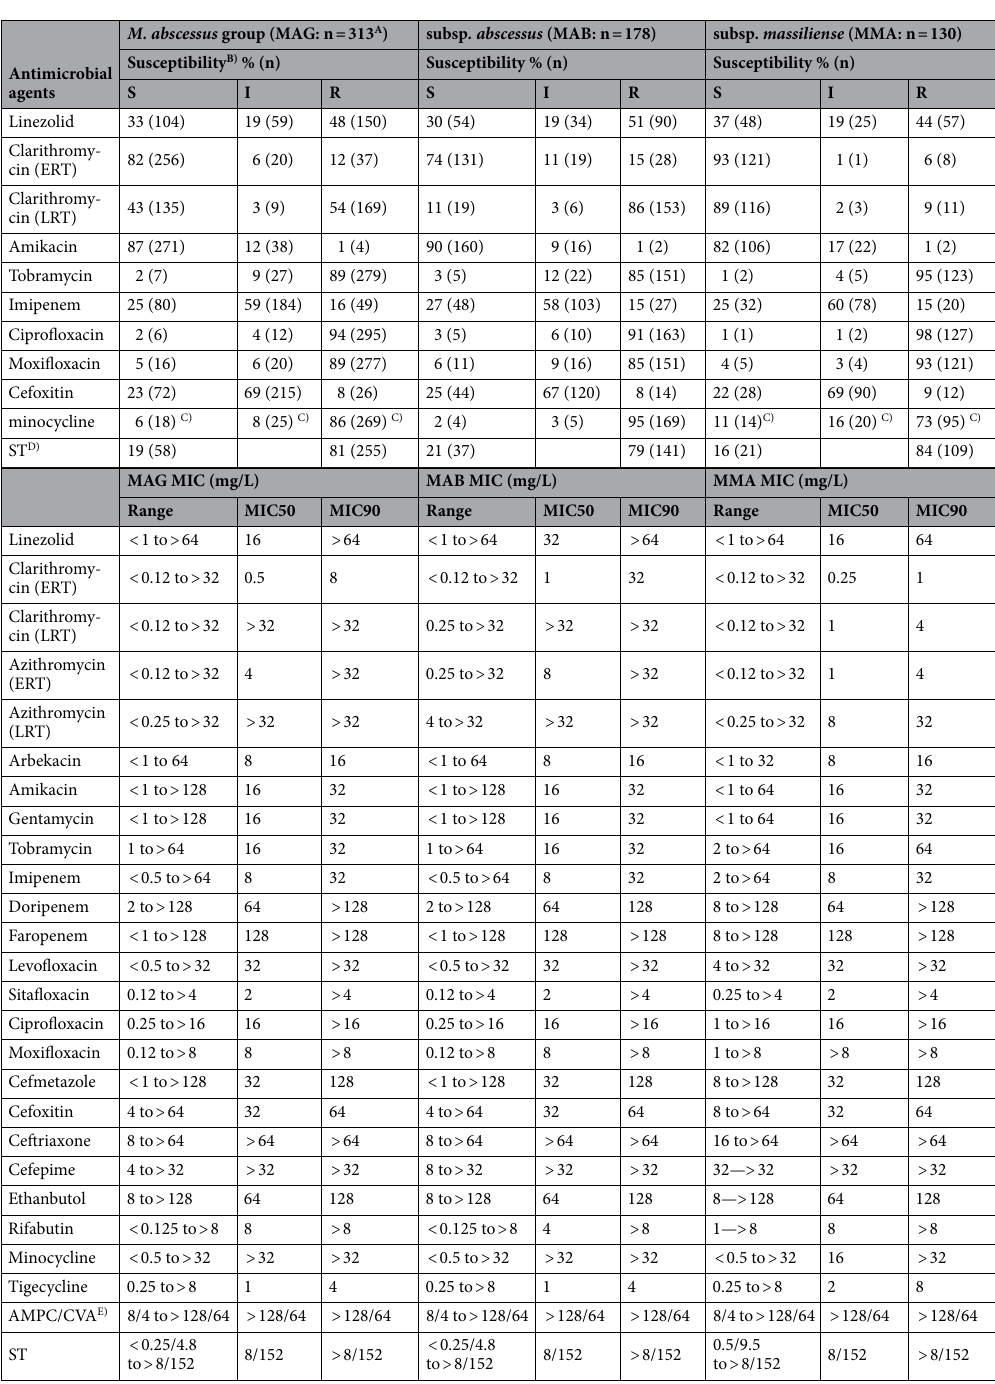
Table 2. Antimicrobial susceptibility of Mycobacteroides abscessus group (MAG) strains. A) These strains included 5 M . abscessus subsp. bolletii (MBO). B) S: Susceptible, I: intermediate, R: resistant. C) Minimum inhibitory concentration (MIC) data for minocycline could not be determined for one strain. D) Trimethoprim/sulfamethoxazole. E) Amoxicillin/clavulanic